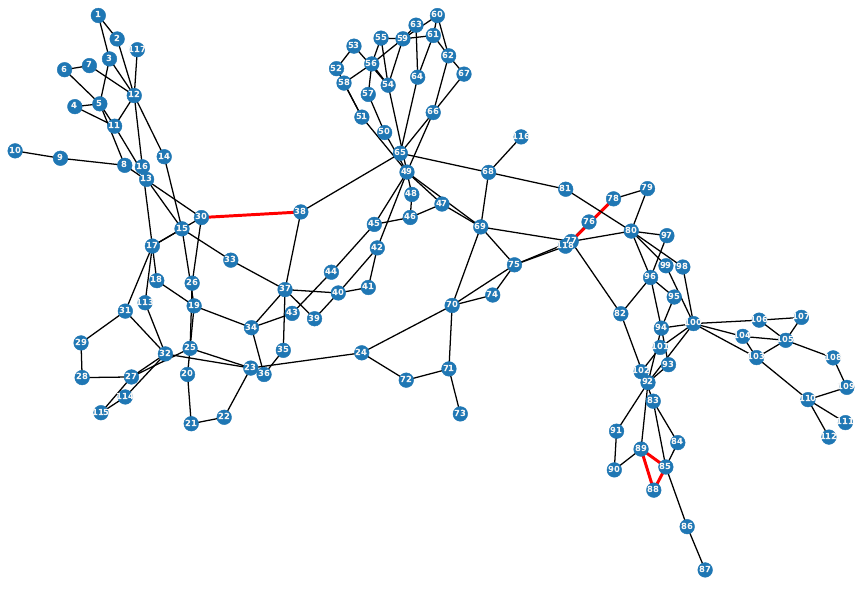
Figure 6. The optimal mobile MSSSC allocation during Season 1. Red lines indicate the mobile MSSSC deployment